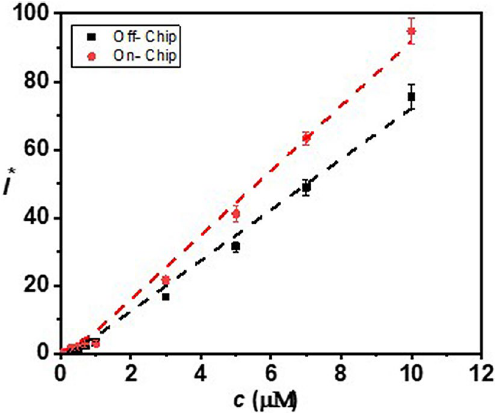
Figure 2. Variation of FL intensity with H 2 O 2 concentration in buffer measured using the microfluidic device with on-chip and off-chip mixing/incubation, linear fits are obtained with R 2 = 0.99 and 0.98, respectively. Each data point represents the standard deviation (SD) from three different